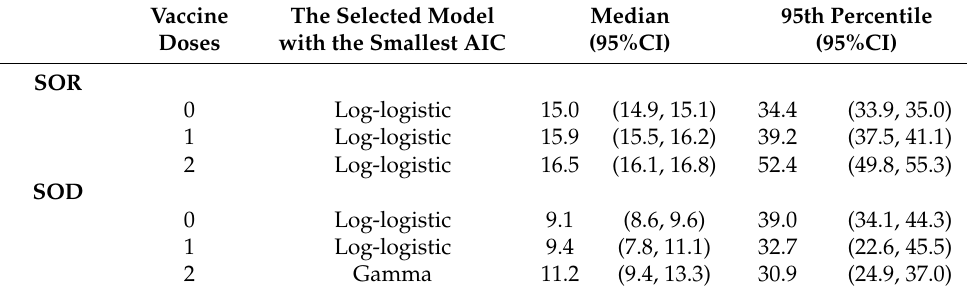
Table 3. The estimated medians of SOR and SOD for cases with vaccination information.